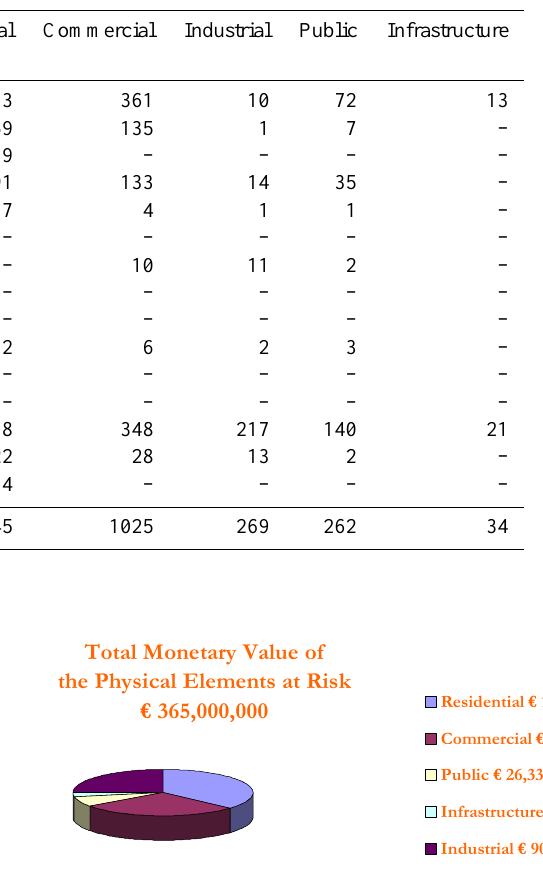
Table 2. Number of buildings within the inundation zone with respect to structural system types, height-wise classification and usage functions.